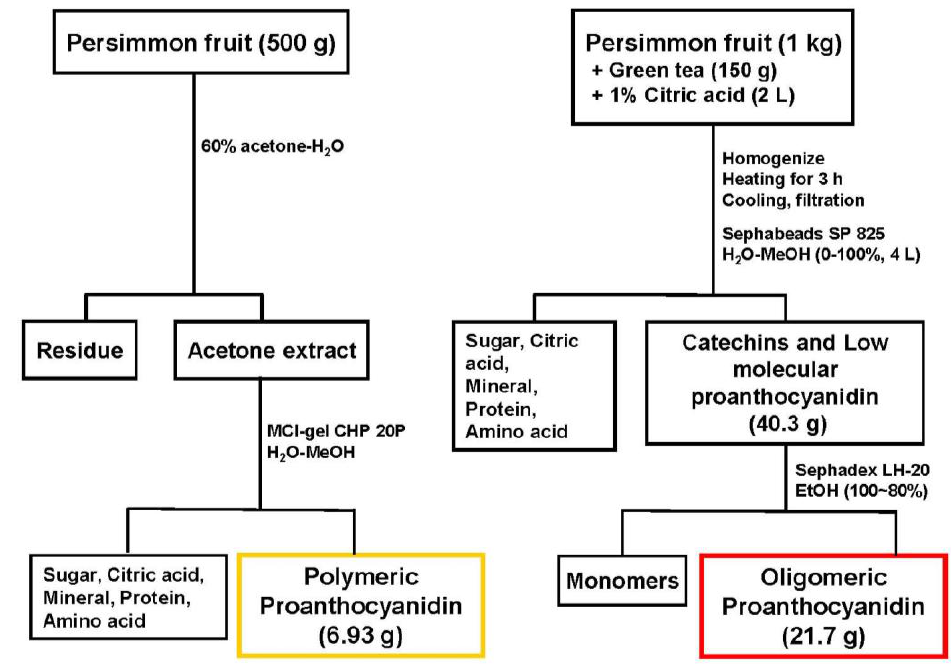
Figure 1. Fractionation of persimmon oligomeric